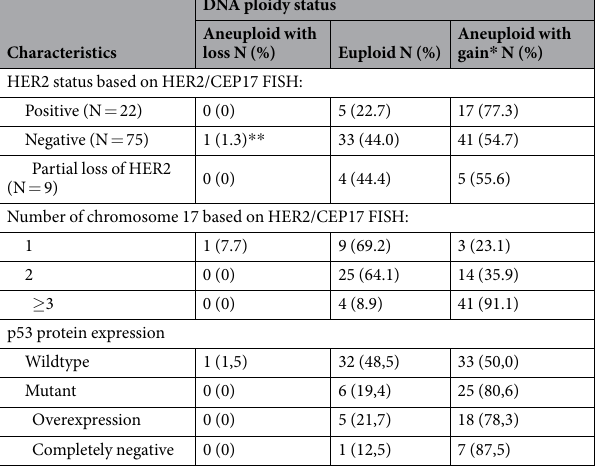
Table 3. DNA ploidy assessment of 97 breast tumours analyzed. N: number of cases. * Including tetraploidy. ** Probably aneuploid with loss, although morphologically it was not possible to differentiate tumour nuclei from normal nuclei.